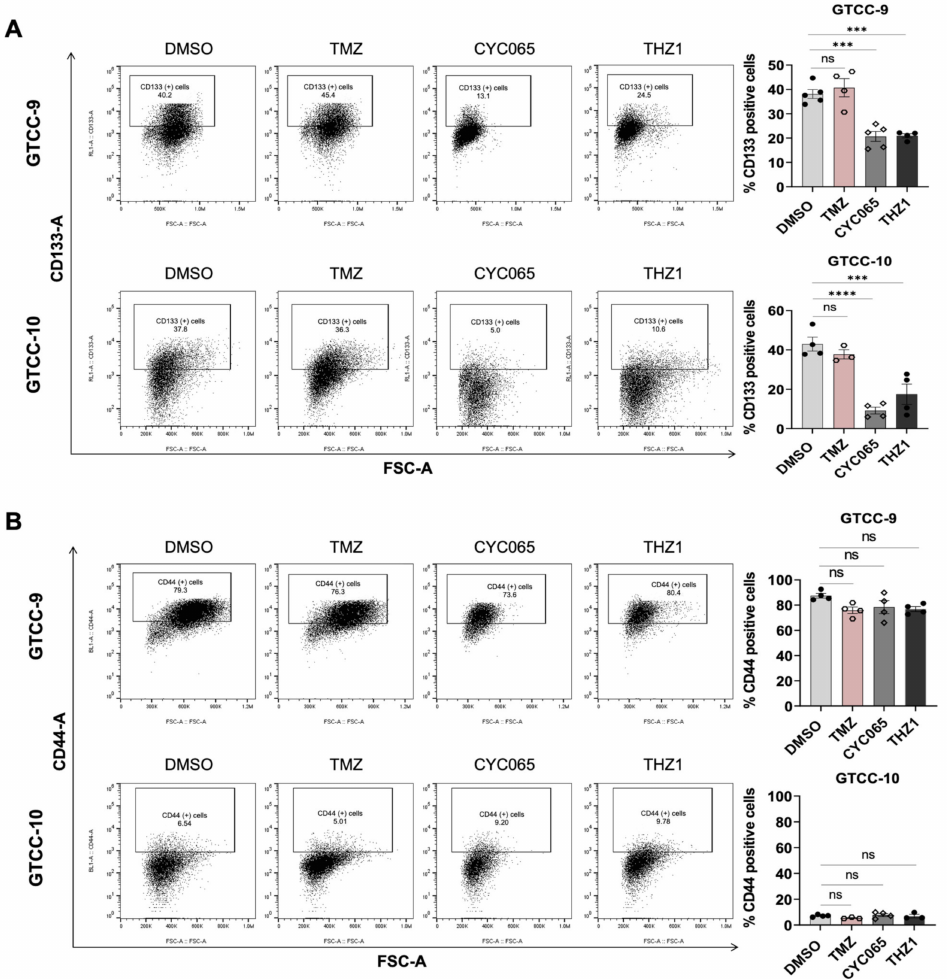
Figure 5. CYC065 and THZ1 decrease the expression of CD133 stem cell marker in recurrent gliomaspheres. ( A , B ) Flow cytometry was used to assess the expression of CD133 and CD44 after 72 h treatment with 150 µ M TMZ, 3 µ M CYC065 or 100 nM THZ1 in GTCC-9 and GTCC-10 recurrent gliomaspheres. Representative plots and quantification of at least three experiments are shown here. Data are expressed as mean ± SEM. One-way ANOVA with post-hoc Tukey’s analysis was used for statistical analysis, whereby, *** p < 0.001, **** p < 0.0001, ns = not significant; gate settings—Figure